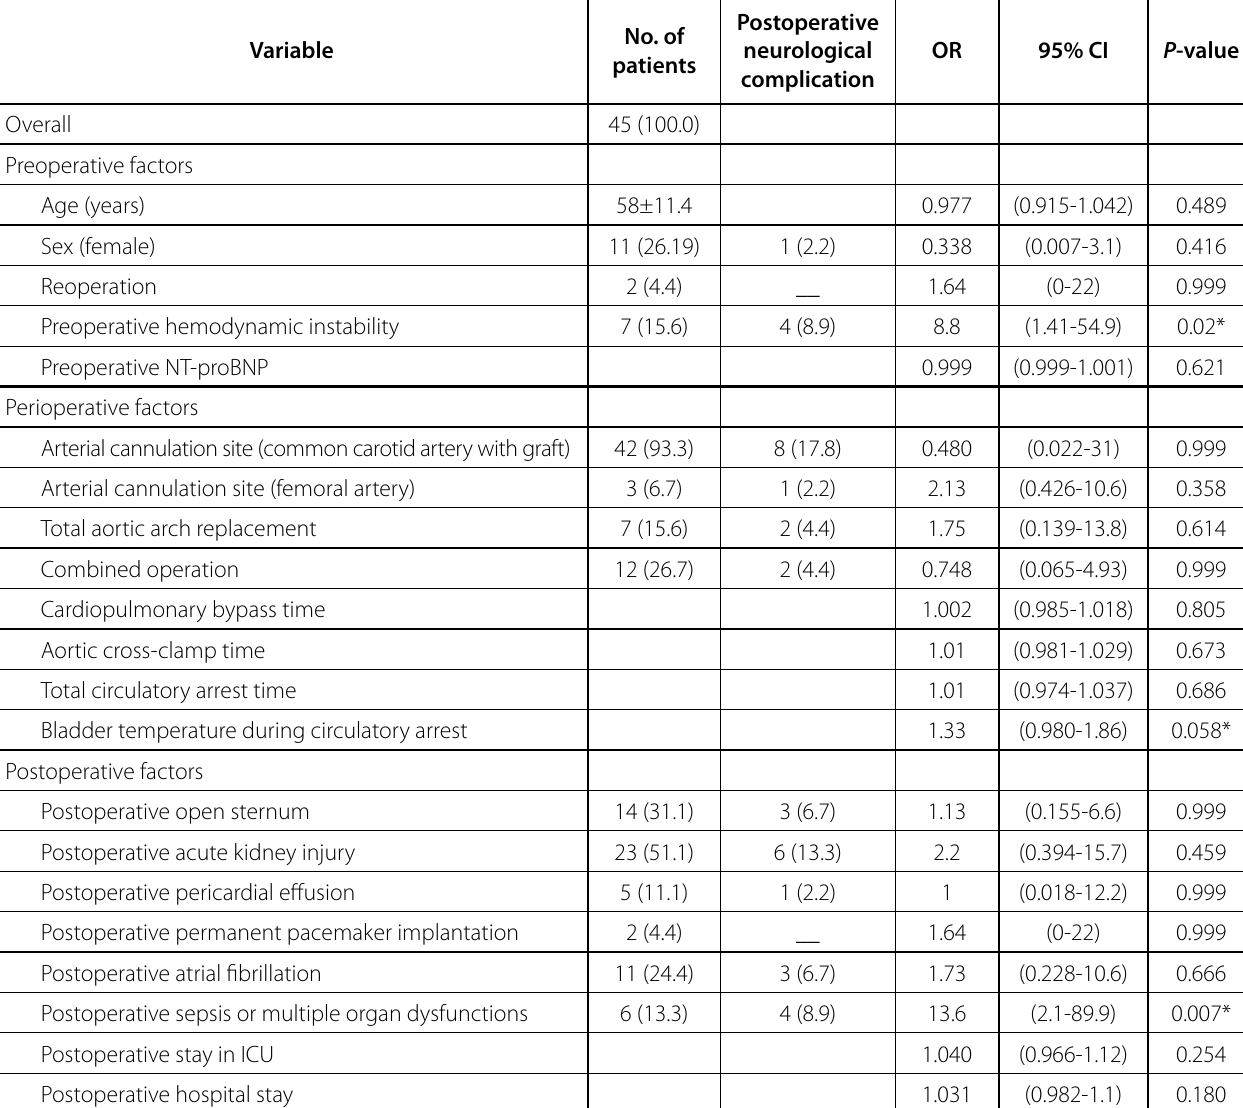
Table 5 . Univariate risk factors for postoperative severe neurological complication.